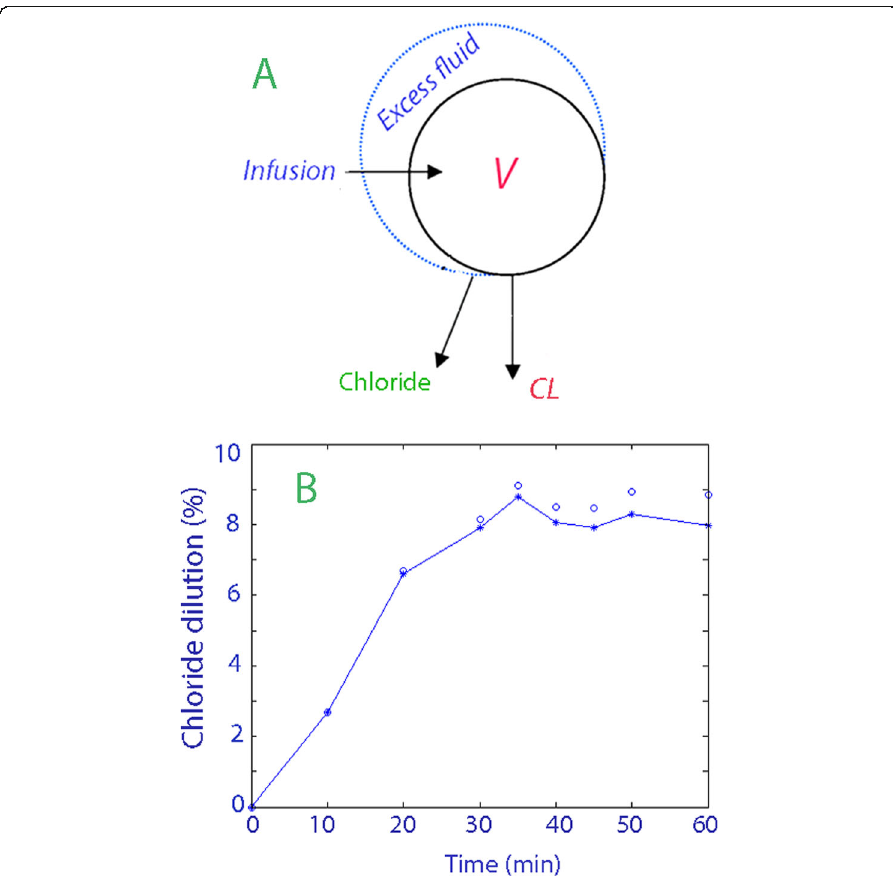
Fig. 1 a Schematic drawing of the model used for the analysis of chloride dilution kinetics. CL is the renal fluid clearance and “ Chloride ” represents the urinary excretion of chloride ions. b Chloride dilution of the extracellular fluid space (ECF). Open circles are the measured chloride dilutions corrected for the addition of Cl with the 0.9% saline and the connected filled circles the dilution after correction also for urinary losses of